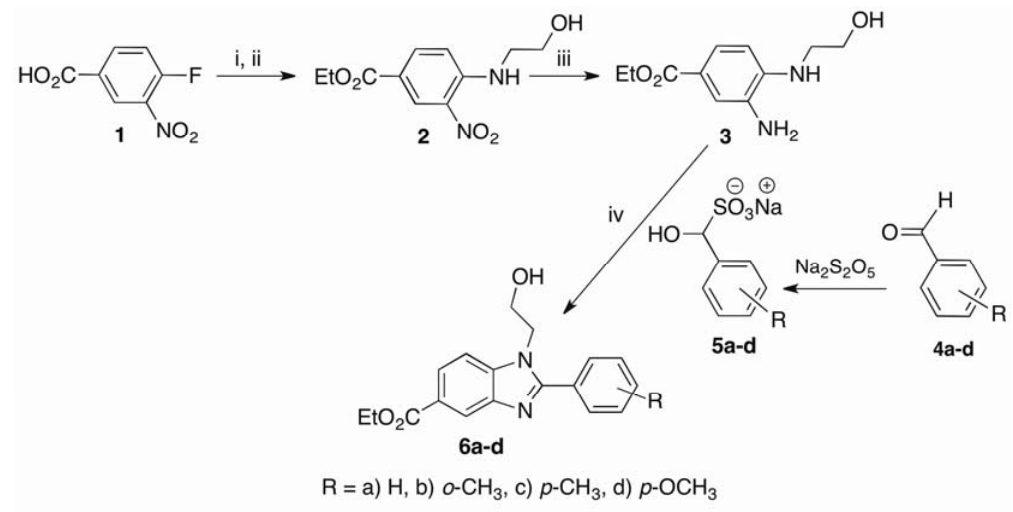
Scheme 1. Synthesis of benzimidazole aglycones 6a – d .